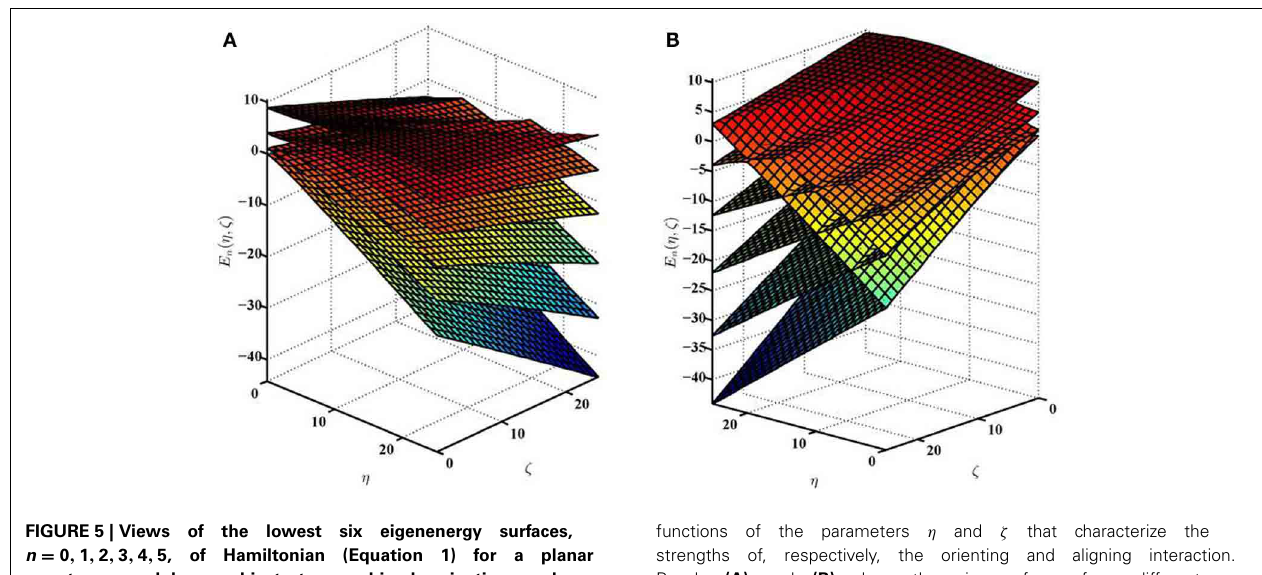
functions of the parameters η and ζ that characterize the strengths of, respectively, the orienting and aligning interaction. Panels (A) and (B) show the eigensurfaces from different